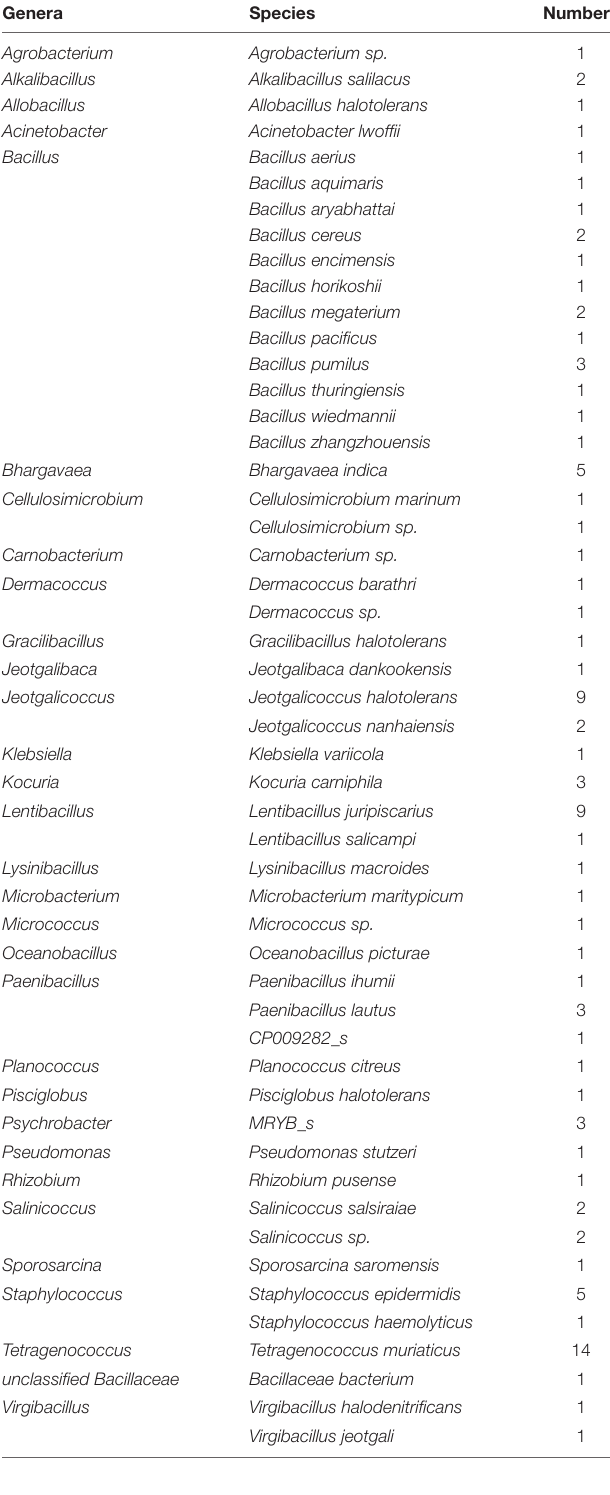
TABLE 1 | Identification of bacteria based on 16S rRNA sequencing. TABLE 2 | Changes in BA contents in grasshopper sub shrimp paste samples during